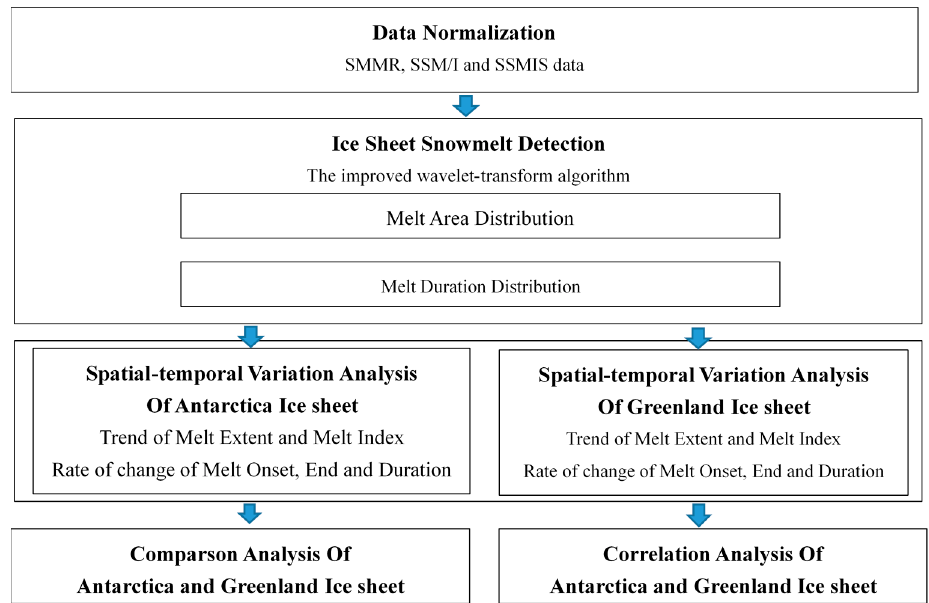
Figure 2. The flowchart of snowmelt detection and analysis of Antarctican ice sheets.